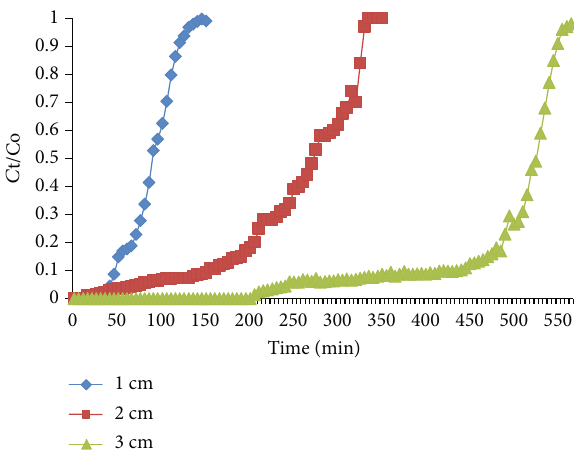
Figure 6: Breakthrough curves of variation of bed height. Figure 7: Breakthrough curves of variation of initial